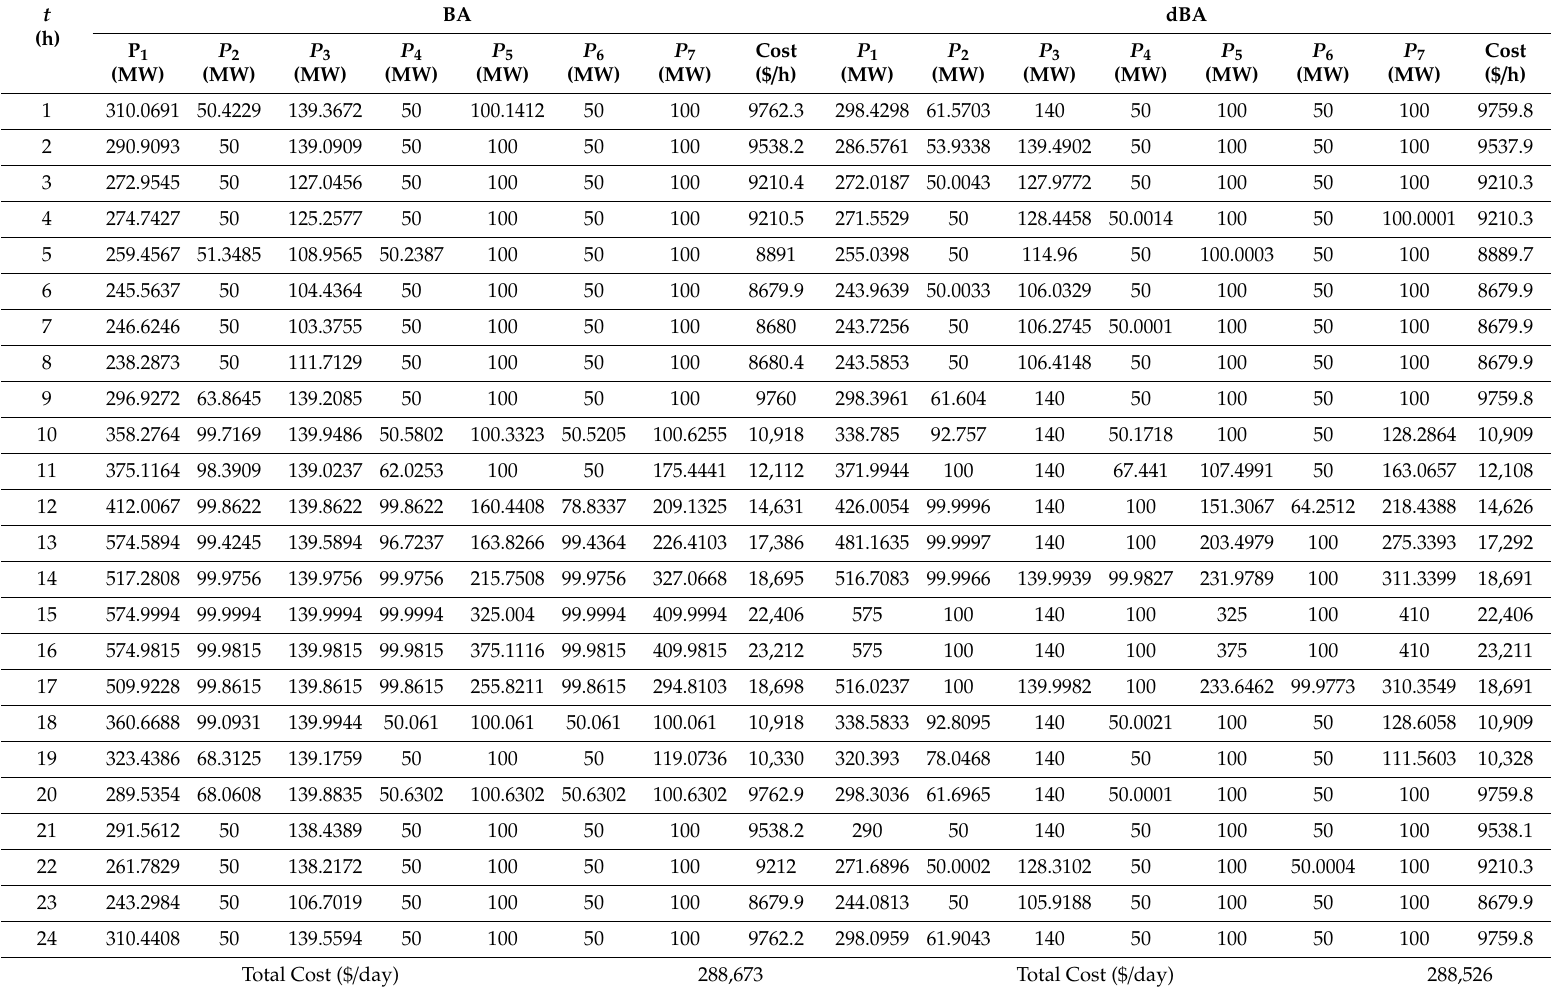
Table 3. BA and dBA on a seven-thermal unit system without